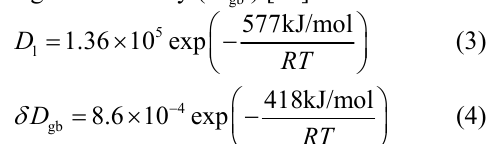
Fig. 3 TEM micrographs for (a) AlN specimen and (b) oxide layer after oxidation at 1150 ℃ for 1 h.